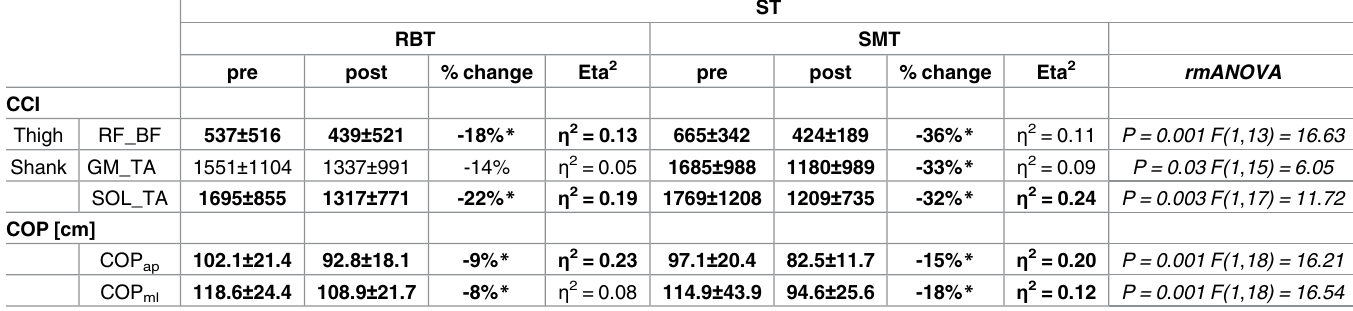
Table 1. Pre and post values of the co-contraction indices (CCIs) and the centre of pressuredisplacement (COP) during Protocol 1 on the spinning top (ST) are illustrated for the two groups RBT and SMT.